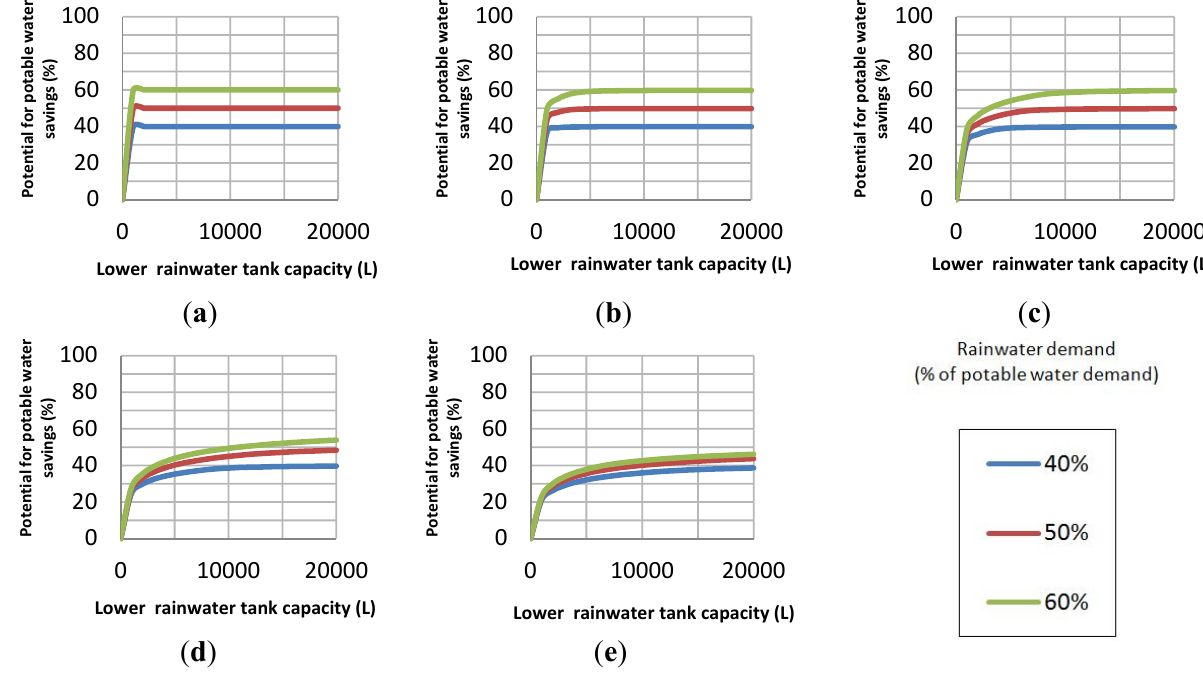
Figure 9. Potential for potable water savings as a function of lower rainwater tank capacity and potable water demand for Berlin, Germany, for a catchment area of 400 m 2 and different potable water demands. ( a ) 100 L per house per day; ( b ) 300 L per house per day;